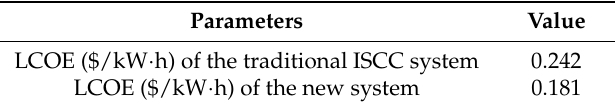
Table 10. The solar energy levelized cost of electricity (LCOE) of different